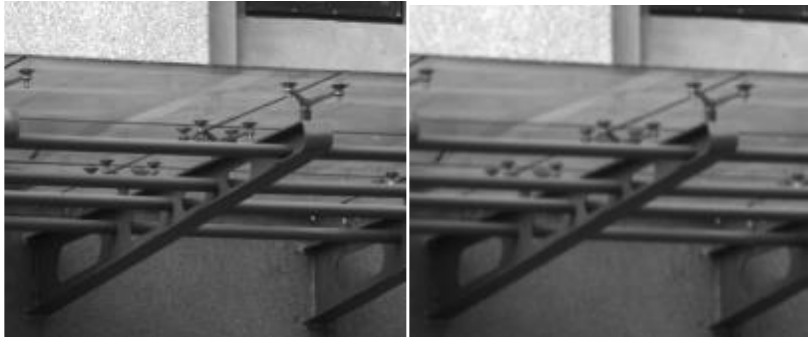
Figure 9. Defocused image sequence for repeatability testing (two randomly selected images).